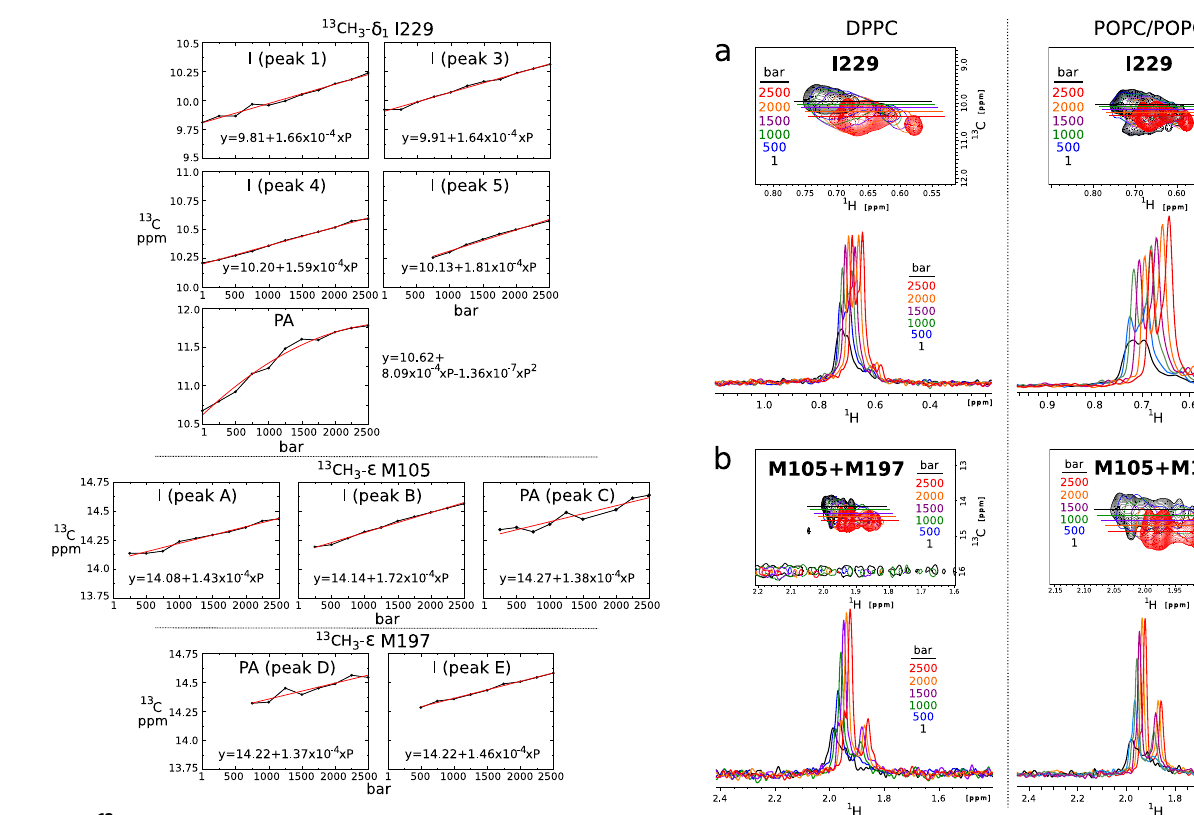
Fig. 8 13 C chemical shift pressure-induced evolutions. Barotropic behavior of δ 1 -I229, ϵ -M105, and ϵ -M197 13 C NMR chemical shifts of apo BLT2 in POPC/POPG nanodiscs. Source data are provided as a Source Data fi le.